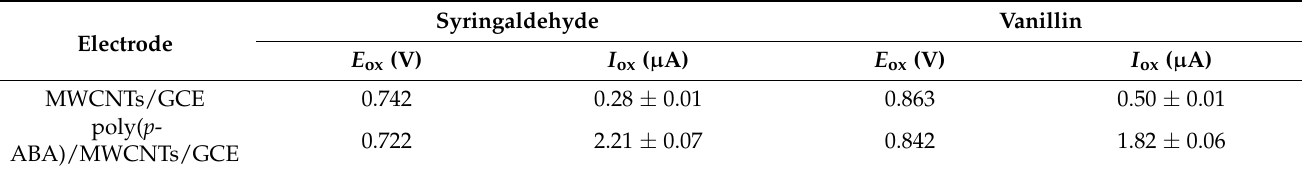
Table 2. Voltammetric characteristics of 10 µM mixture of aromatic aldehydes at the MWCNTs- and poly( p -ABA)-modified electrodes in Britton – Robinson buffer pH 2.0 ( n = 5; P = 0.95).